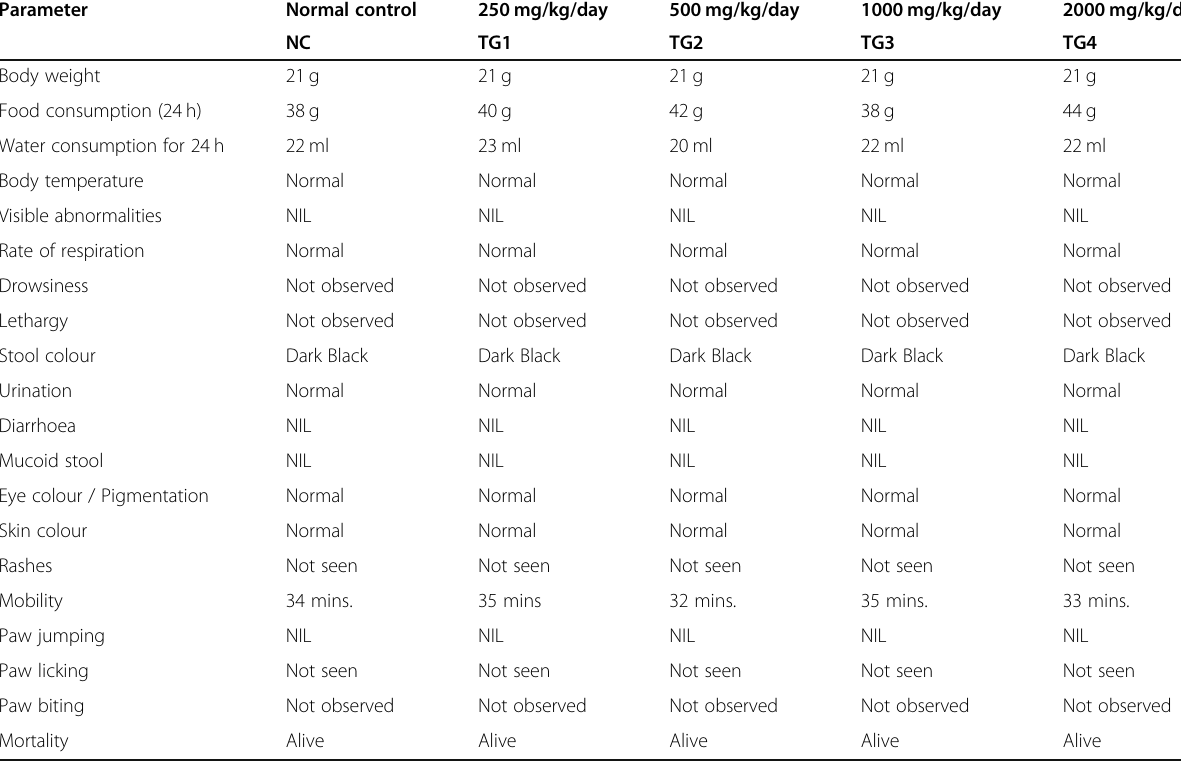
Table 2 Effect of polyherbal combination (PHC) on physical and behavioral parameter in mice during 14-day acute toxicity